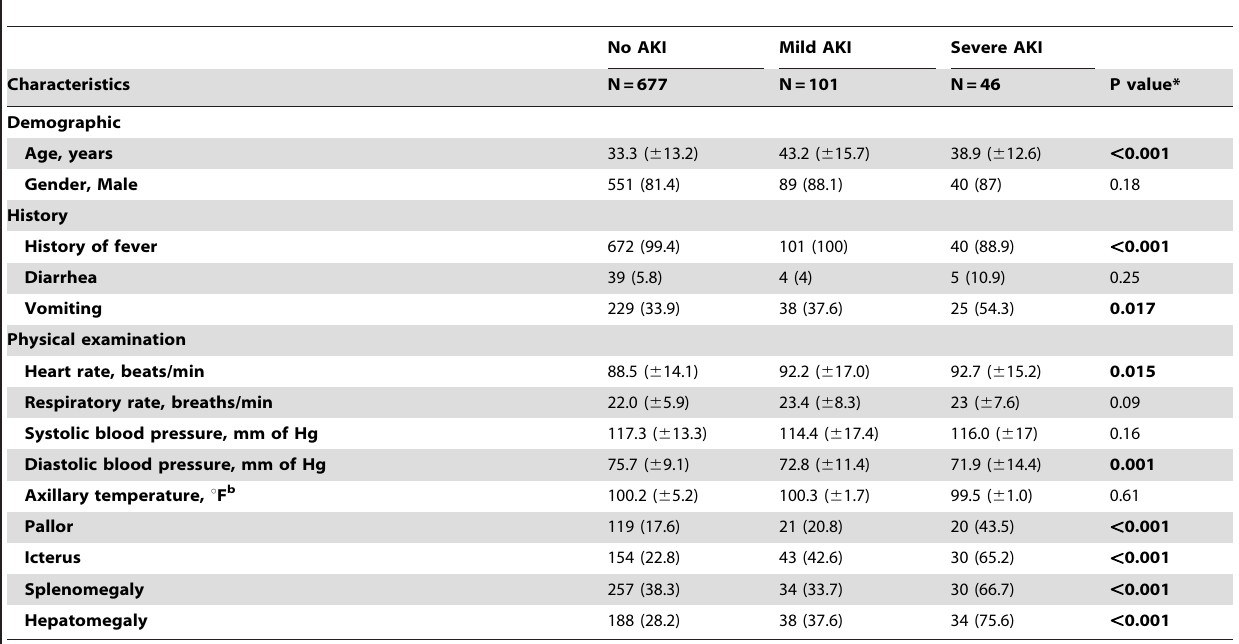
Table 1. Demographic and clinical characteristics of the patients stratified by AKI categories. a